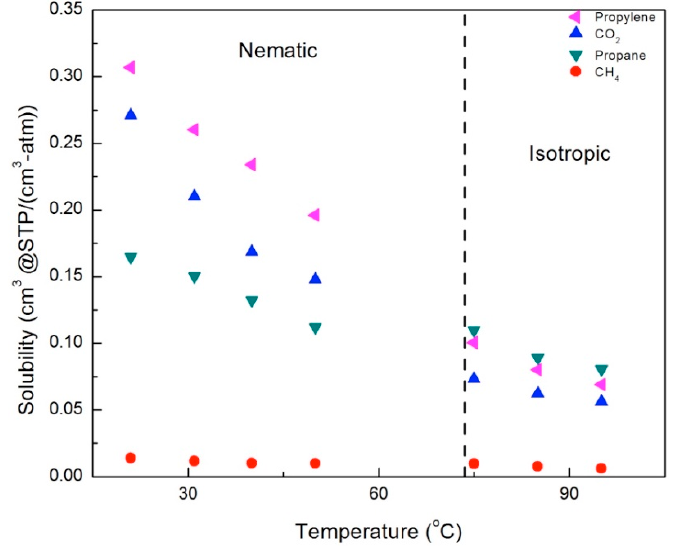
Figure 13. Solubilities for gases in the membrane CNBPh75_2.5 (2.5% crosslinker) in the nematic and isotropic phases.